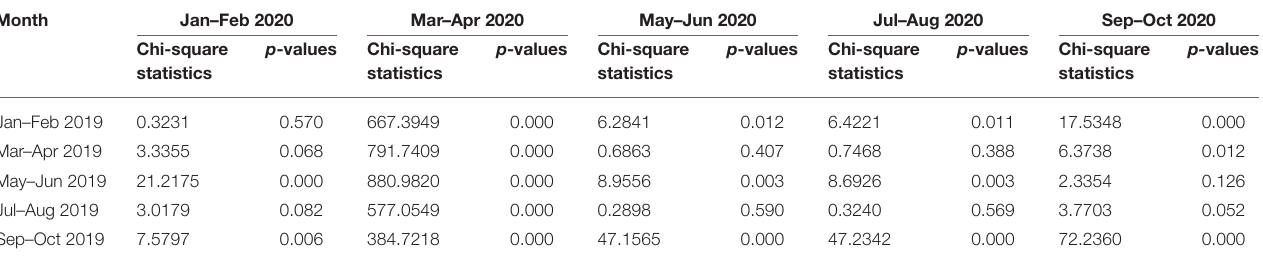
TABLE 4 | Telehealth visit counts in 2019 and